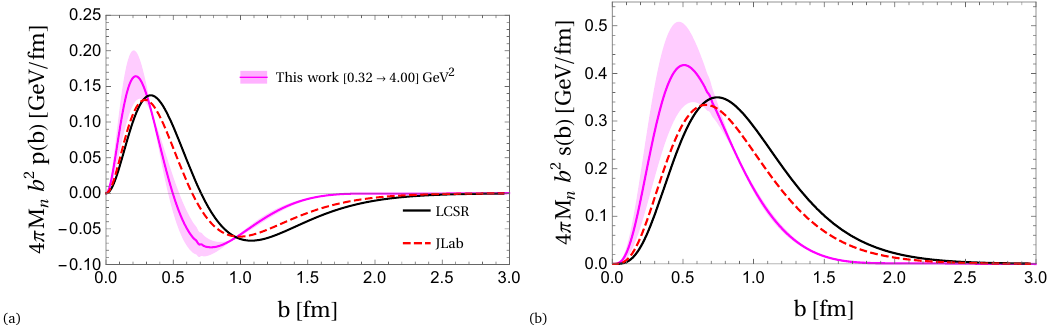
b 2 p ( b ) , and (b) the shear dis- n